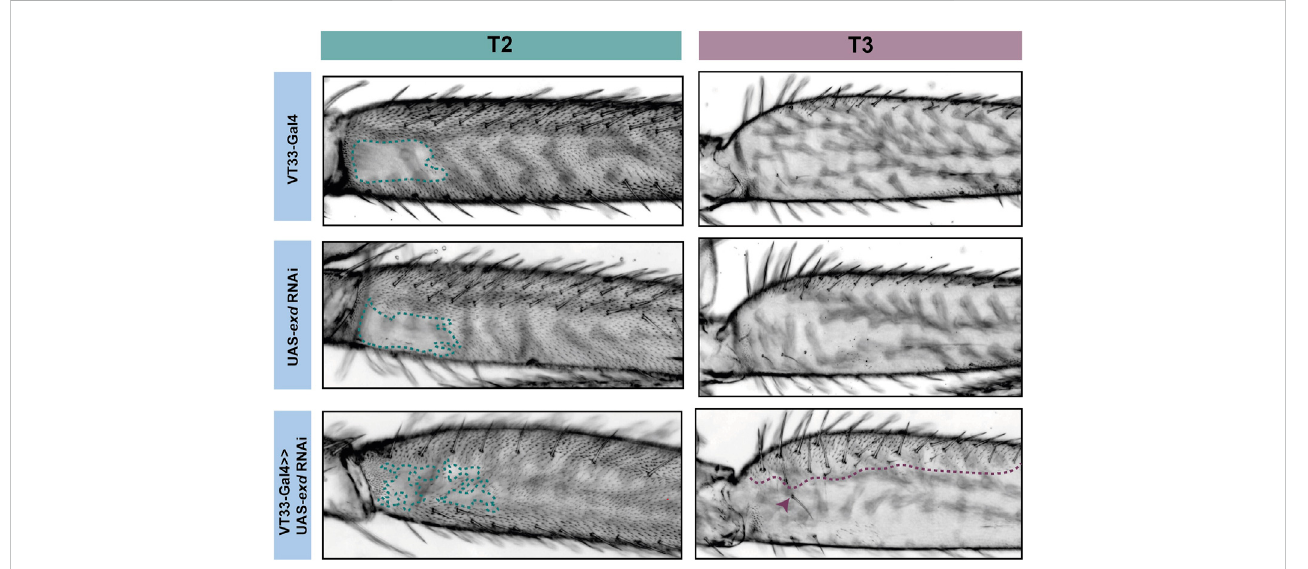
FIGURE 5 RNAi knockdown of exd results in ectopic trichome growth. exd RNAi results in patchy ectopic trichomes in the NV of T2 femurs (green). On T3 femurs (purple), exd RNAi also causes the development of ectopic trichomes, which extend about one-third from the proximal dorsal towards the ventral (purple dotted line). There is also an additional row of bristles as well as ectopic bristle growth